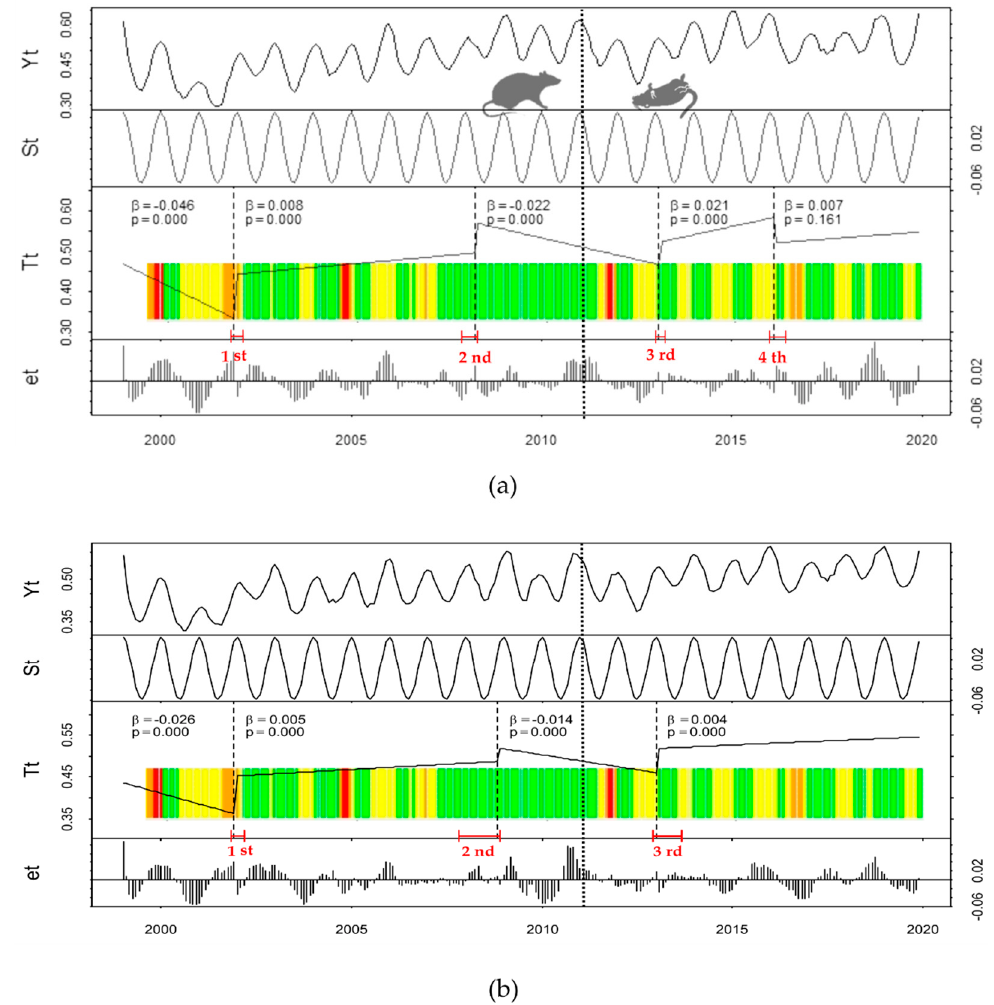
Figure 7. Decomposed NDVI data (Yt) into seasonal (St), trend (Tt) and remainder (et) components for NDVI timeseries between 1999 and 2020 for both treatment zone ( a ), and control zone ( b ), using the breaks for additive seasonal and trend (BFAST) method. The dotted vertical line shows when the rodent eradication campaign took place (February 2011). The dashed lines in Tt represent the timing of each significant NDVI change ( p < 0.05) in the trend component, together with its 95% confidence intervals (horizontal red bars). Ordinal numbers are used to name the breakpoints. Vertical axis units are absolute NDVI values. The slope coefficient ( β ) and p -value is shown for each fitted trend segment. Colored slots represent Hydrological Drought Index (HDI) between March 1999 and December 2019 [95] which describe the water resources state from more to less abundant for: normality (green), pre-alert (yellow), alert (orange), and emergency